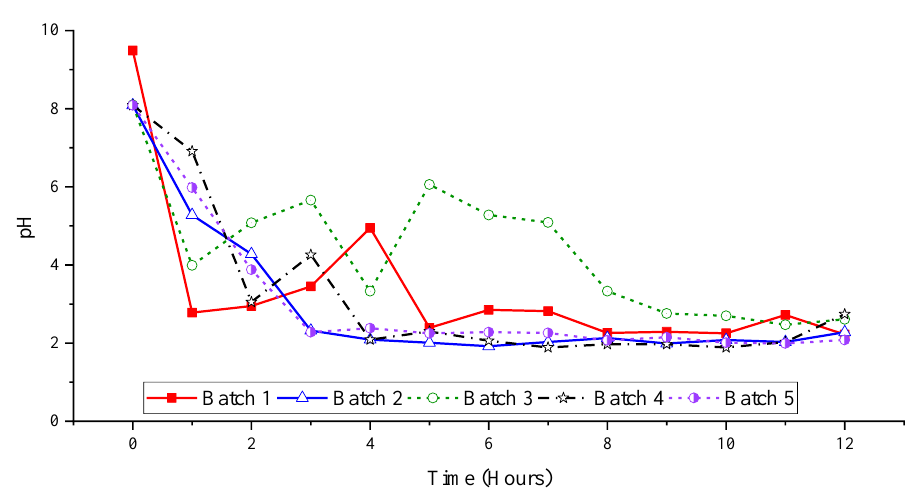
Figure 3. Effect of ozone and perozone sparging on pH value of groundwater.